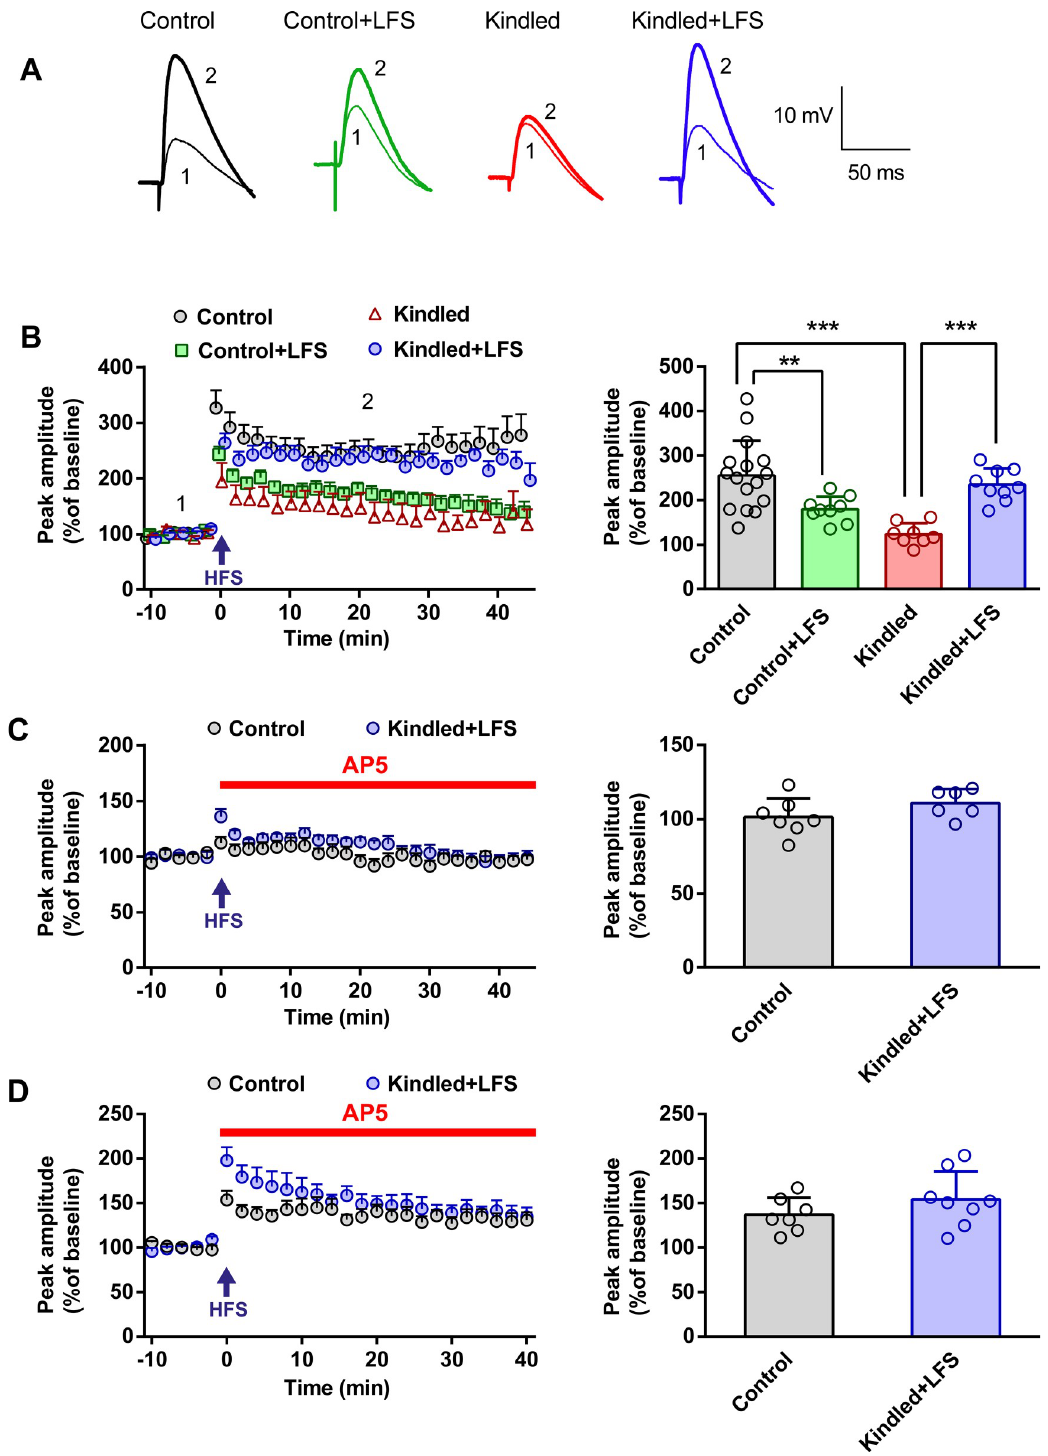
Fig 1. Improvement of eLTP induction in hippocampal slices of kindled animals following LFS application. (A) EPSPs sample recordings of different experimental groups, before (1) and after (2) HFS application. The numerals near the traces correspond to the times indicated by the same numerals in the graphs. (B) Left: Time course of the EPSP amplitude alteration (% of the baseline) within 40 min after HFS delivery. In the kindled group, eLTP was attenuated significantly compared to the control group. Also, impairment of eLTP induction was restored following LFS administration in the kindled animals. In addition, delivery of LFS